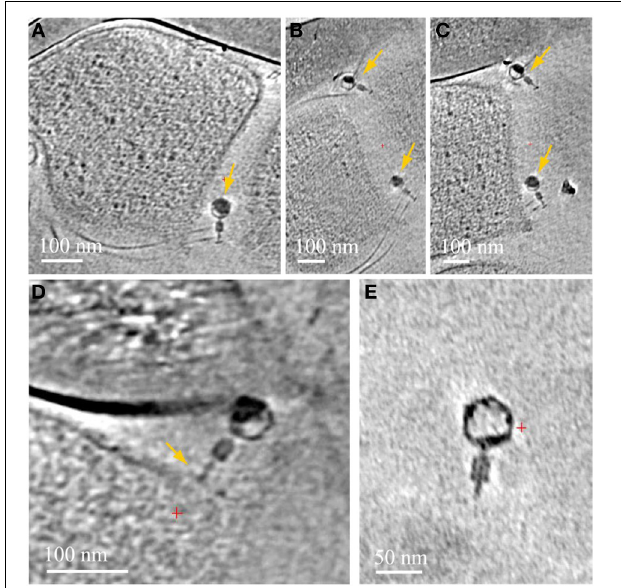
FIGURE 7 | Associations between viruses and Thermoplasmatales pili. Computational slices through 3D cryo-ET reconstructions of Thermoplasmatales lineage archaea associated with viruses. (A) A virus attached to pili, close to the cell surface; (B,C) two slices at different heights and angles through the same reconstruction as in (A) , with two viruses attached to pili, yellow arrows. Pili are very thin and a series of slices are needed to capture them, and the viruses, in-plane of the slices respectively. The top and bottom viruses are shown in Supplementary Information Movies 7 , 8 respectively. (D) avirusattachedtoacellsurface. (E)